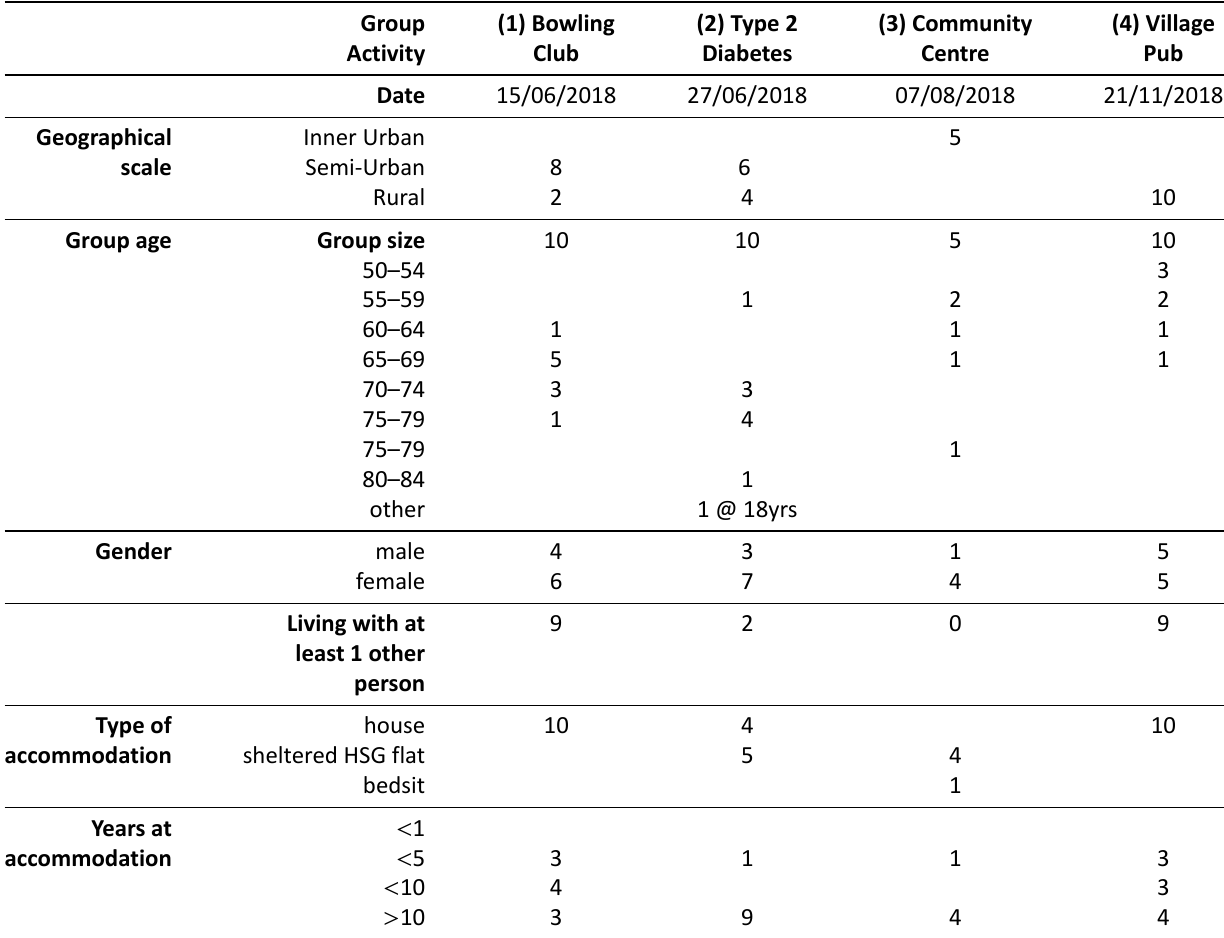
Table 2. Focus group demographic: Information gathered through a short